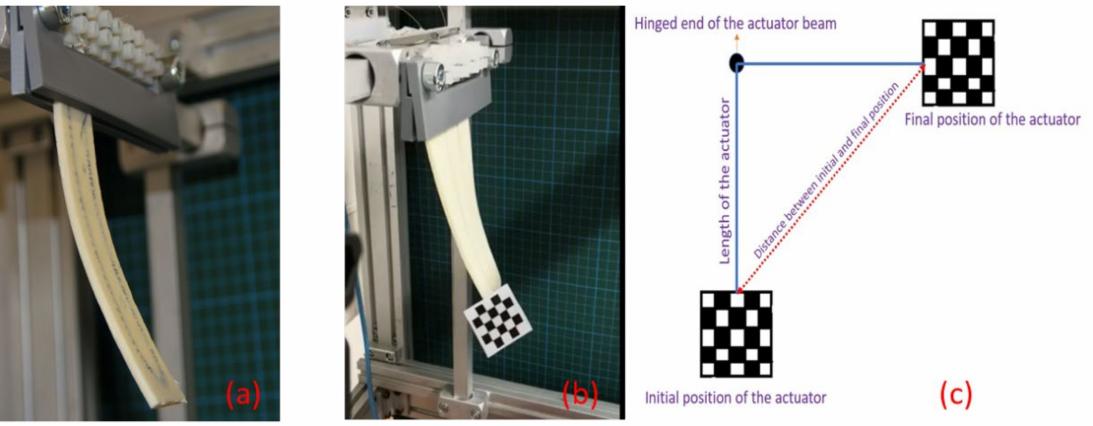
Figure 3. Actuation setup: ( a ) specimen of LBR-based interactive fiber-rubber composite clamped and with the SMA wires connected to the voltage supply via a screw terminal; ( b ) the bending of the structure was monitored by optical markers; and ( c ) the bending distance was defined as